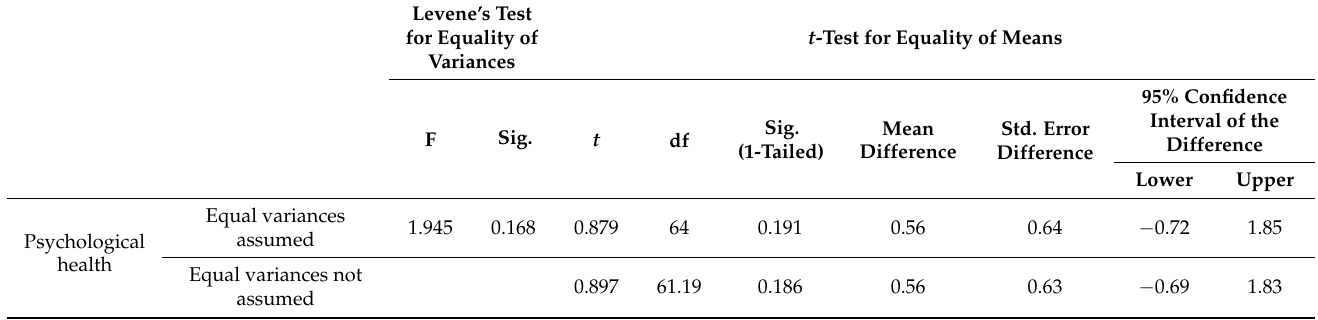
Table 4. Calculation of the p -value using the t -test for psychological health. Levene’s Test for Equality of